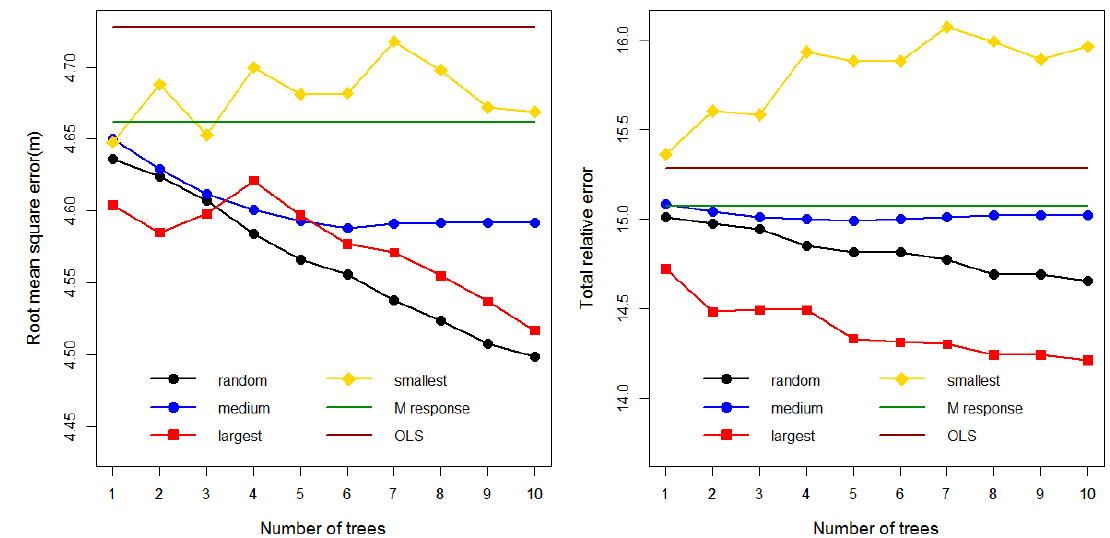
Figure 4. Root mean squared error (RMSE) for ordinary least square (OLS) Equation (7), Equation (19) with mean response (M response), and Equation (19) calibrated with four sampling strategies and sample sizes for diameter at breast height within each sub-sample plot, for estimating the random e ff ects (random: randomly selected trees; largest: the largest trees; medium: medium-size trees; and smallest: the smallest trees).